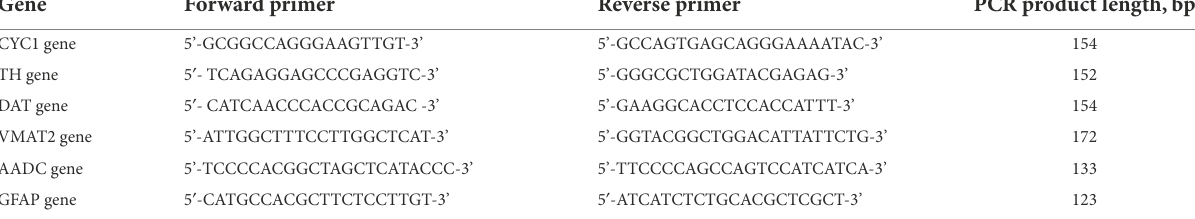
TABLE 1 Oligonucleotide primers used for